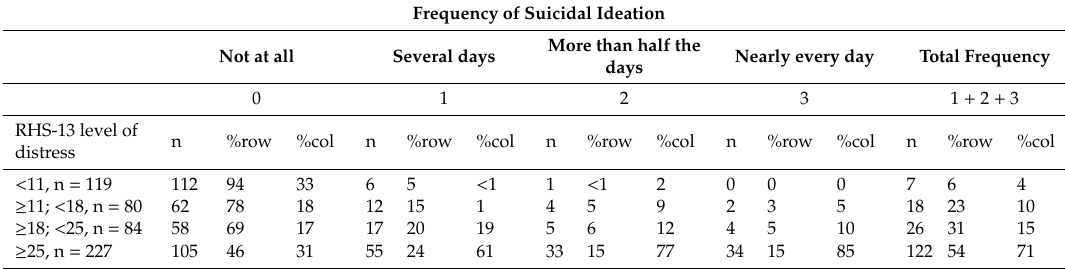
Table 1. Prevalence of suicidal ideation by distress severity level on the RHS as assessed by item 9 in the PHQ-9. Number of respondents, percentage within each distress severity level and within each group is